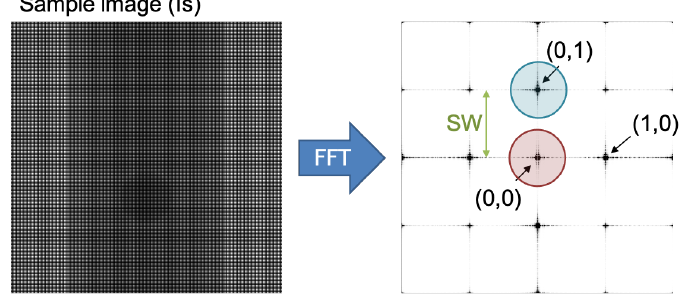
Figure 9. Mesh-Based imaging phase retrieval principle. Simulated sample image with a phantom and a grid. The Fourier transform of this image contains the Fourier transform of the sample convoluted to a Dirac comb. The harmonics contain various pieces of information about the sample.